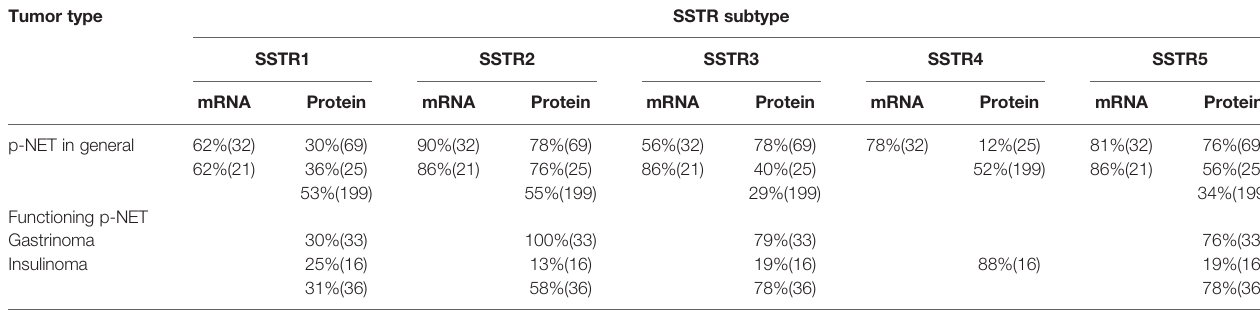
TABLE 2 | SSTR expression in